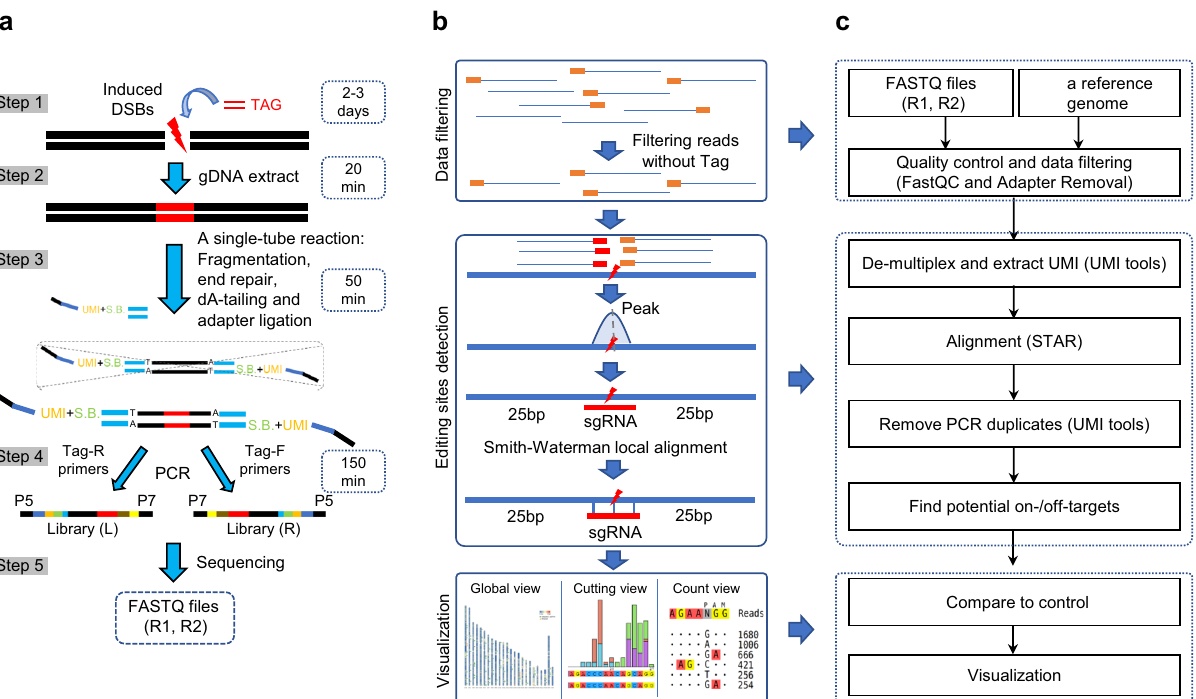
Fig. 1 Overview of Tag-seq and its bioinformatics analysis work fl ow. a Schematic of Tag-seq. It involves fi ve steps: cell transfection, genomic DNA extraction, a single-tube reaction (including fragmentation, end repair, dA-tailing and adapter ligation), PCR ampli fi cation, and next-generation sequencing. It spends ~2 – 3 day + 220 min for libraries preparation. b The Tag-seq data analysis work fl ow contains three parts: data fi ltering, editing sites detection, and visualization. c Tag-seq data analysis scheme. It starts with only FASTQ fi les (R1, R2) and a reference